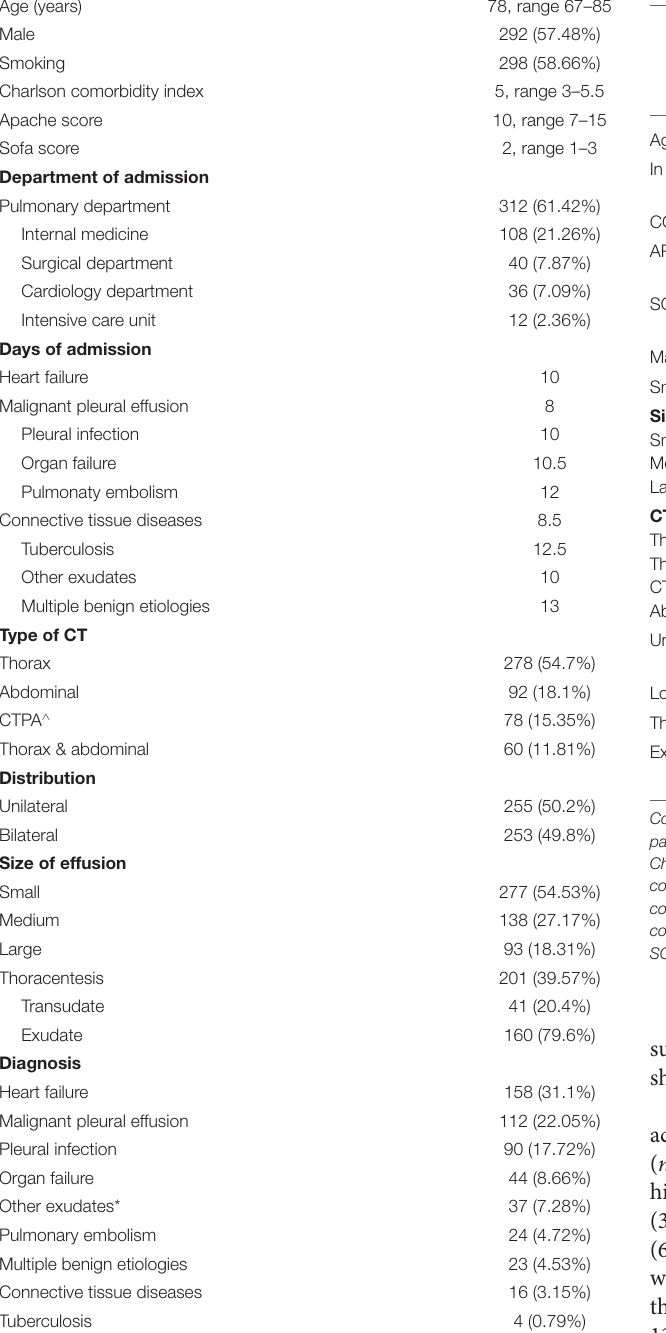
TABLE 1 | Demographics and characteristics of pleural effusions ( n = 508). TABLE 2 | Comparative characteristics of subjects based on short and long-term